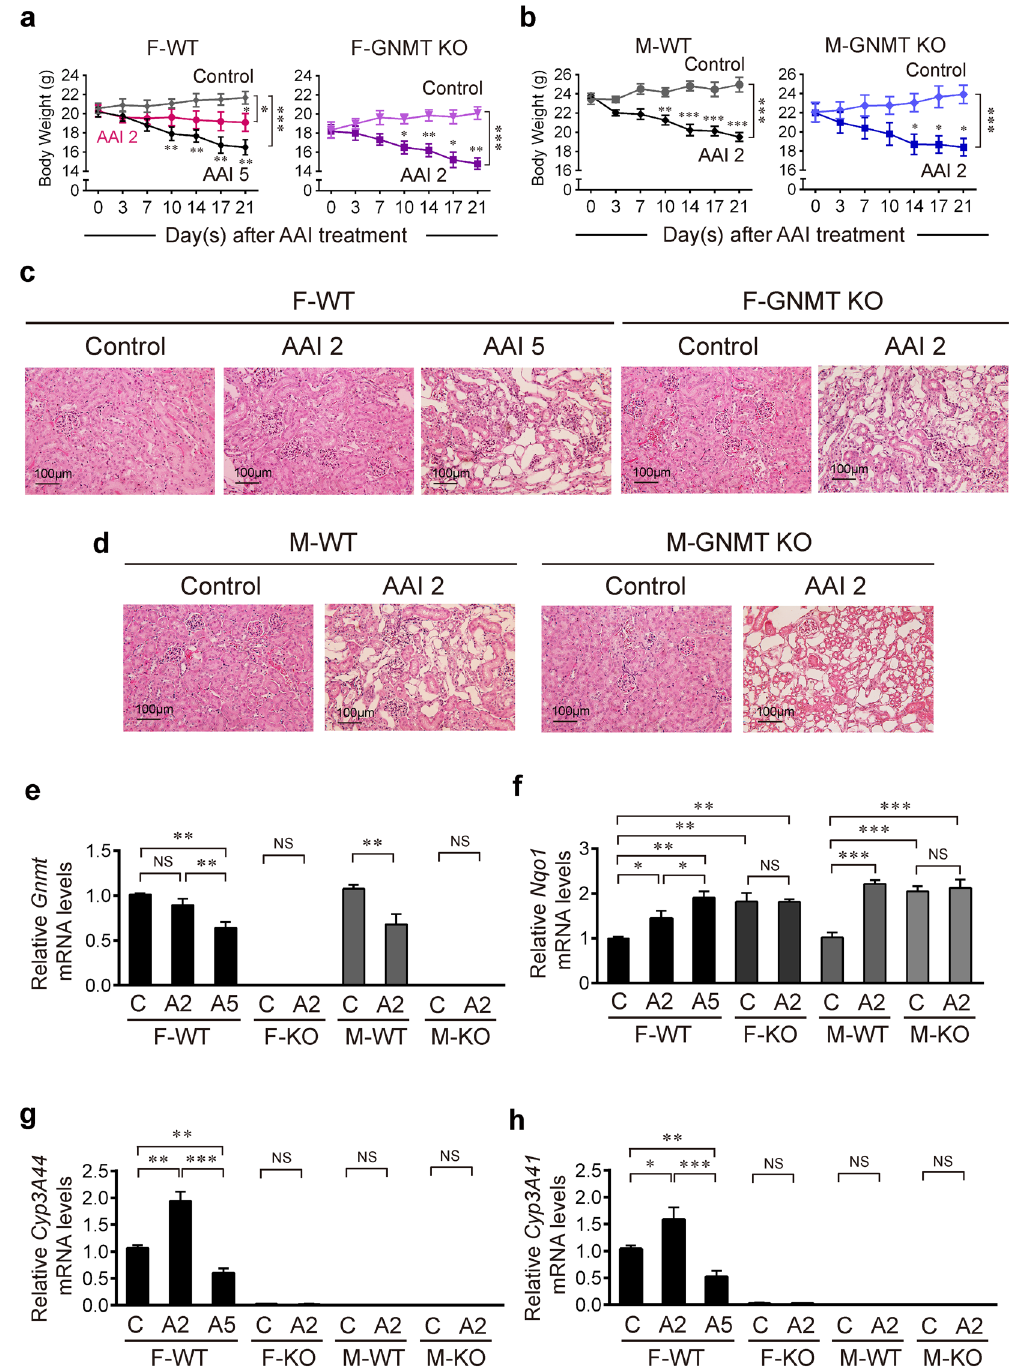
Figure 4. GNMT knockout female mice lose tolerance to AAI. ( a,b ) Body weight of GNMT knockout (GNMT KO) or wild-type (WT) mice intraperitoneally injected with 2 or 5 mg/kg/day AAI (AAI 2 or AAI 5) or corn oil (vehicle control), 5 days/week for 3 weeks. Values are presented as the mean ± SEM, n = 4. p - values were calculated by two-way ANOVA and Sidak’s multiple comparisons test. ( c,d ) Histological analysis of renal morphology in corn oil- or AAI-treated mice, as described in ( a , b ) (hematoxylin and eosin stain, original magnification × 200). ( e–h ) mRNA level of Gnmt, Nqo1, Cyp3A4, and Cyp3A41 genes in the liver of AAI- or corn oil-treated WT or GNMT KO mice, as described in ( a , b ), were determined by qPCR. Data were normalized to β -actin. (A2, A5: 2 or 5 mg/kg BW/day AAI administration, C: vehicle control) Values are presented as the mean ± SEM, n = 5. p -values were calculated using Student’s t -test. * p < 0.05, ** p < 0.001, *** p ≤